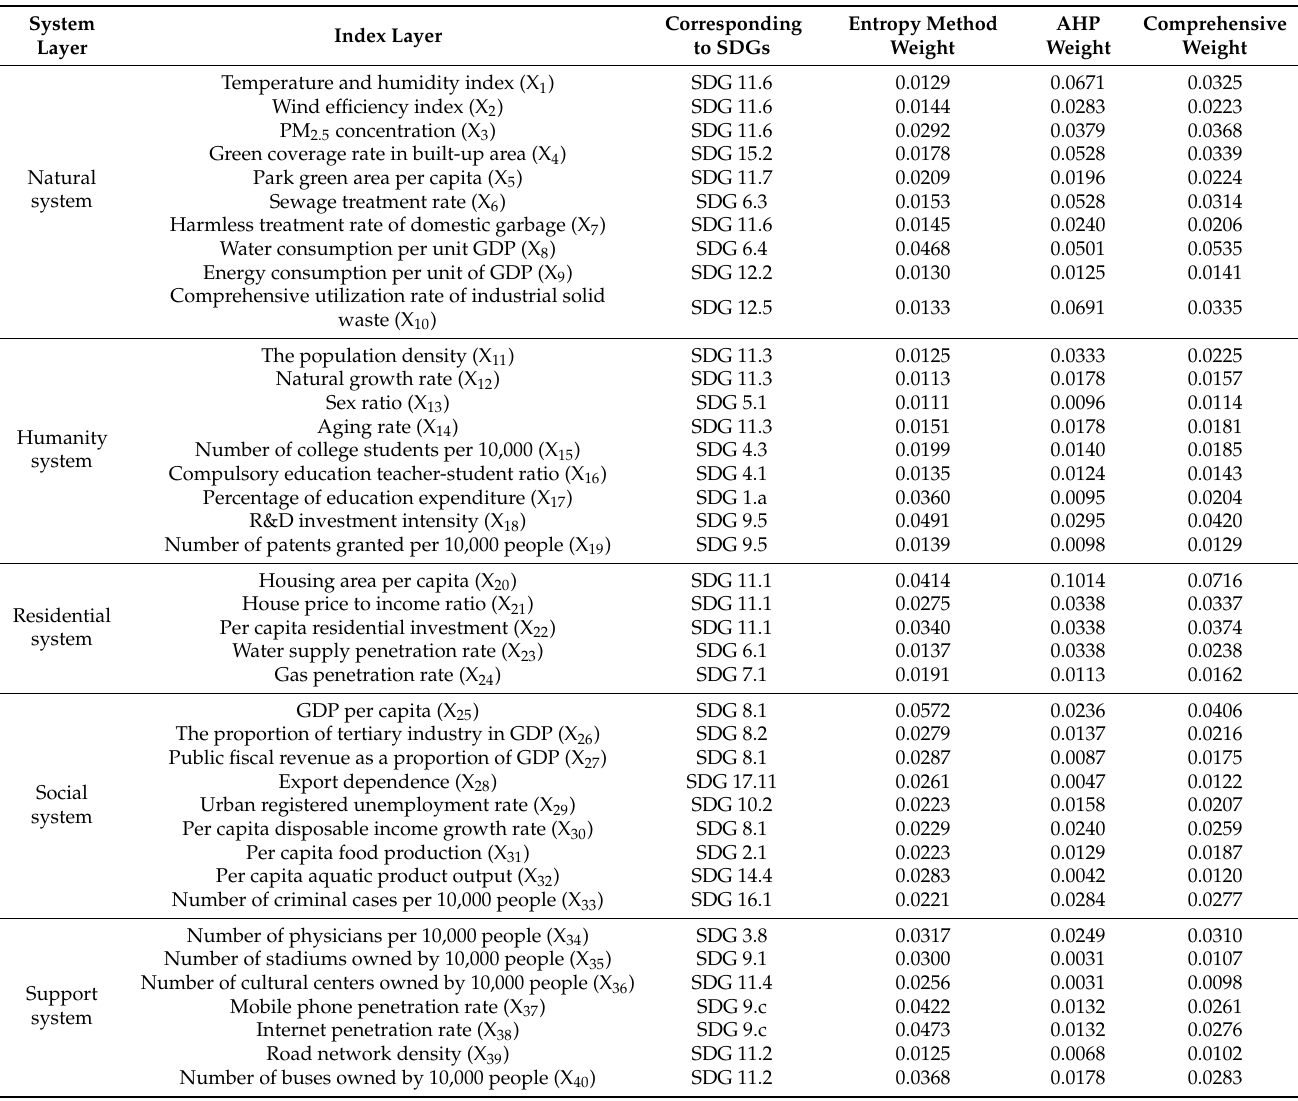
Table 1. Index system and weight of sustainable development of urban human settlements in